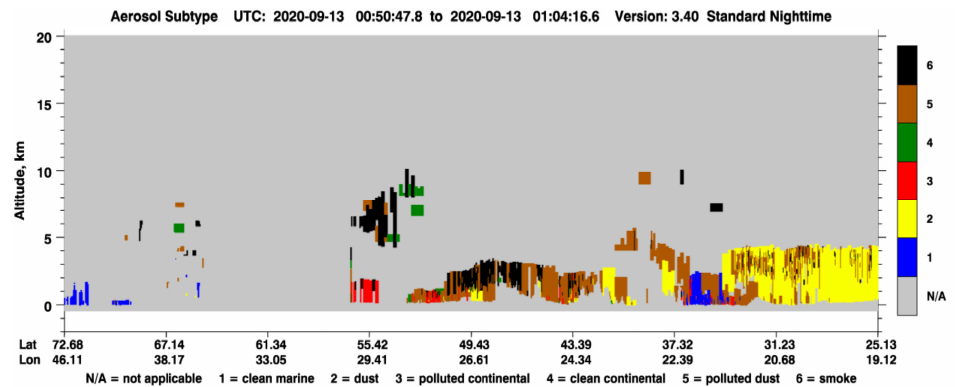
Figure 4. Detection of dust aerosol over the Black Sea region by CALIPSO methods for 13.09.2020.